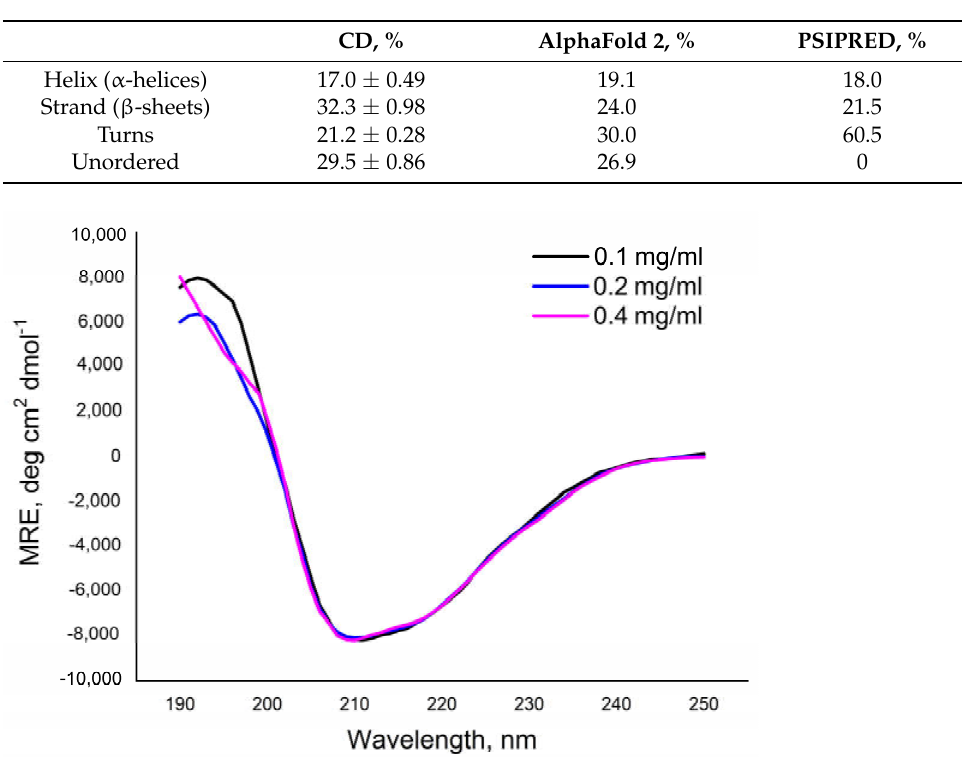
Figure 5. The circular dichroism spectra of the Svx protein of Pectobacterium atrosepticum in 10 mM Tris-HCl buffer (pH 8.0). Table 1. The percentage of the secondary structure elements of the Svx protein of Pectobacterium atrosepticum calculated based on the circular dichroism spectroscopy data, AlphaFold 2 modeling and PSIPRED.